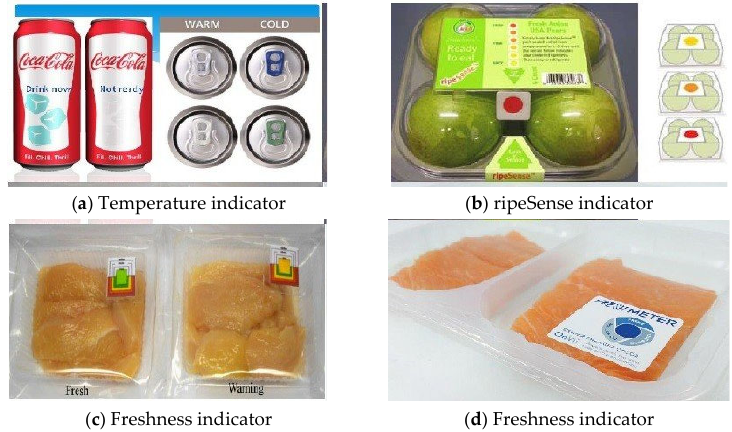
Figure 3. Applications of intelligent packaging systems, modified from Neši ć et al. [64]. ( a ) Temperature indicator; ( b ) ripeSense indicator; ( c ) Freshness indicator [65]; ( d ) Freshness indicator. Table 2. Different types of intelligent